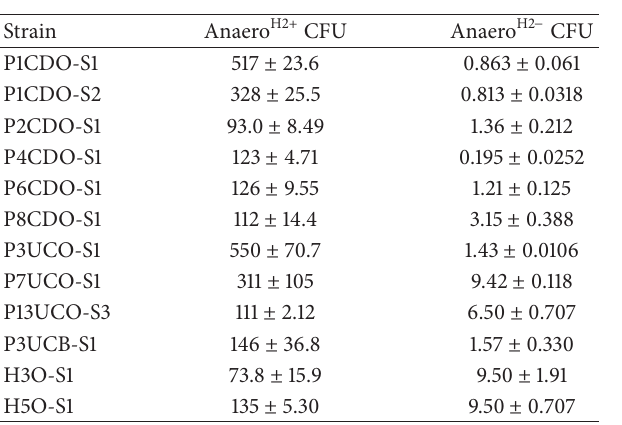
Table 2: CFU of C. concisus strains cultured under Anaero H2+ and Anaero H2 − conditions.